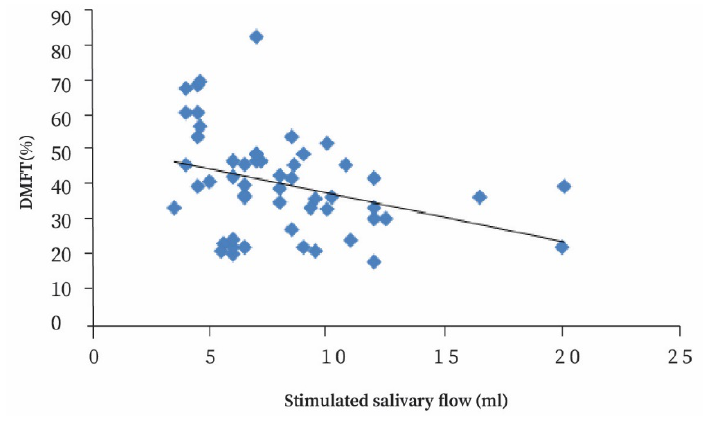
Figure 1. DMFT variation as a function of the stimulated salivary flux (ml) .